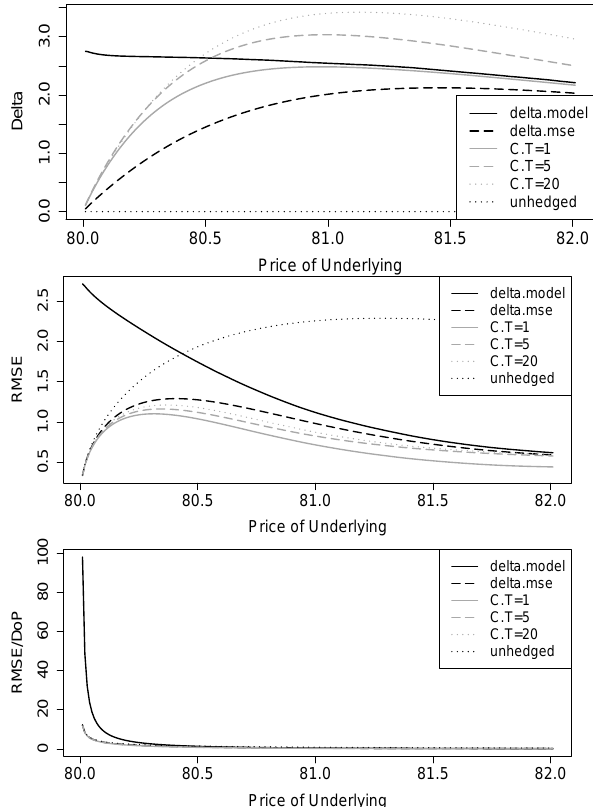
Figure 7. Jump diffusion model with discrete hedging in continuous time: deltas, absolute and relative root mean squared hedging errors. Hedging object is a down-and-out put with K = 100, B = 80, and T = 20 days; the hedging period is ∆ t = 1 day. The hedging strategies are standard (model-implied) delta (delta.model), MSE delta using the underlying (delta.mse), MSE delta using vanilla calls with time to maturity of 1 (C.T = 1), 5 (C.T = 5), and 20 (C.T = 20) days, and no hedging